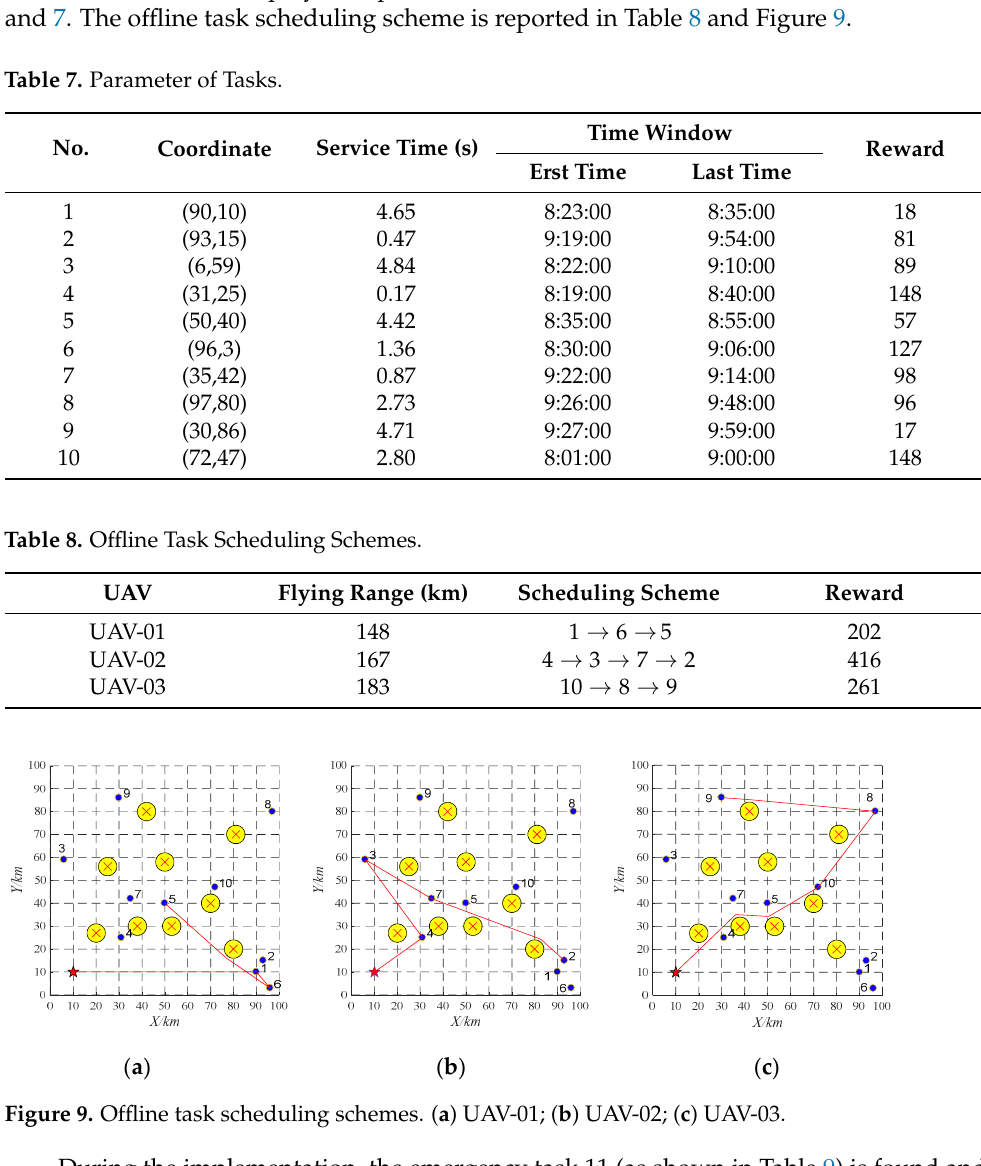
(2) Task re-scheduling based on replacement contract